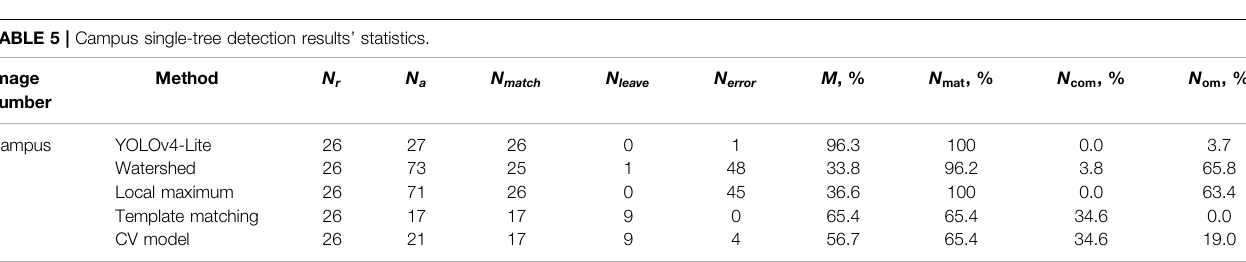
TABLE 5 | Campus single-tree detection results ’